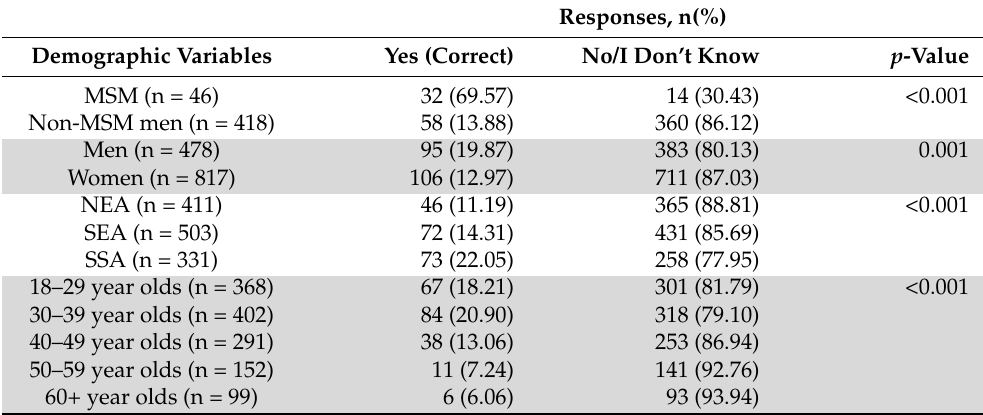
Table 3. Responses to PrEP knowledge question (Are there any medicines that people can take BEFORE SEX to protect themselves against HIV?) by demographic